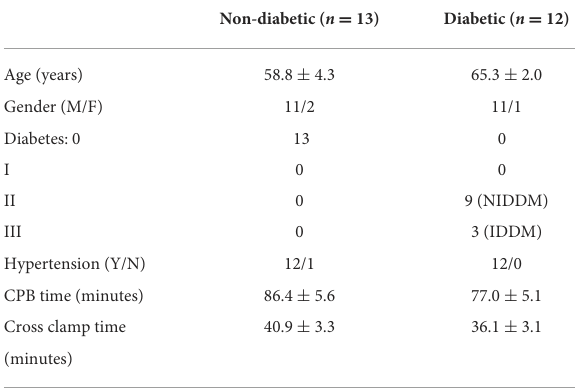
TABLE 2 Characteristics of diabetic and non-diabetic CABG patients. Non-diabetic( n =